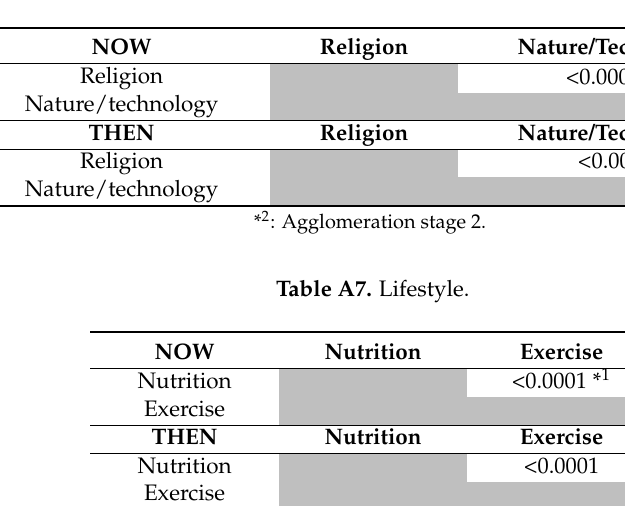
Table A6. Beliefs/attitudes.